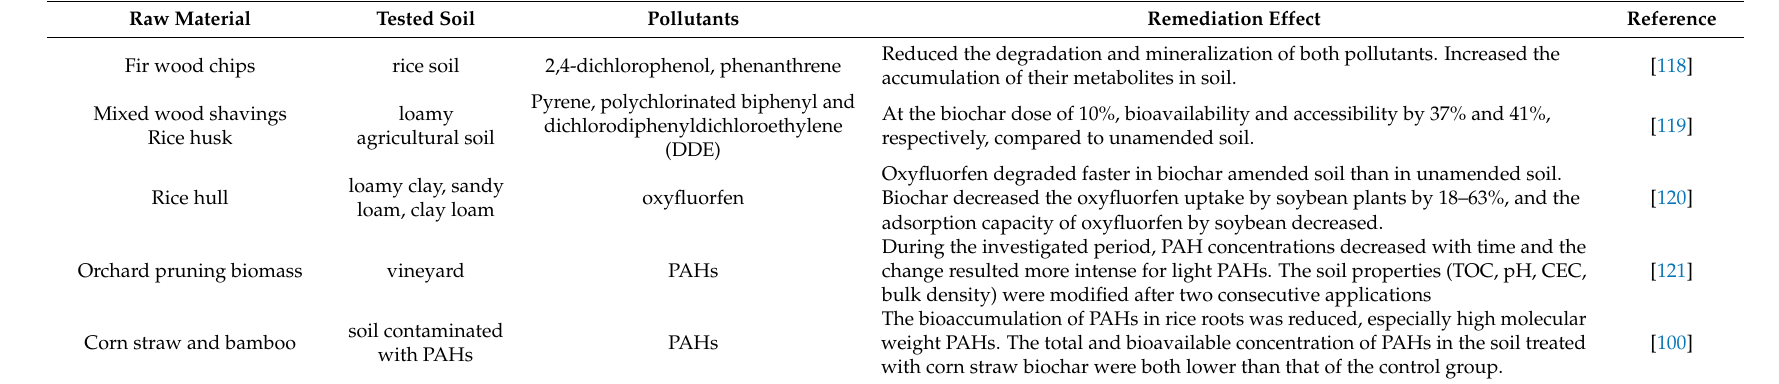
Table 6. Study on the application of biochar to remove persistent organic pollutants (POPs) in